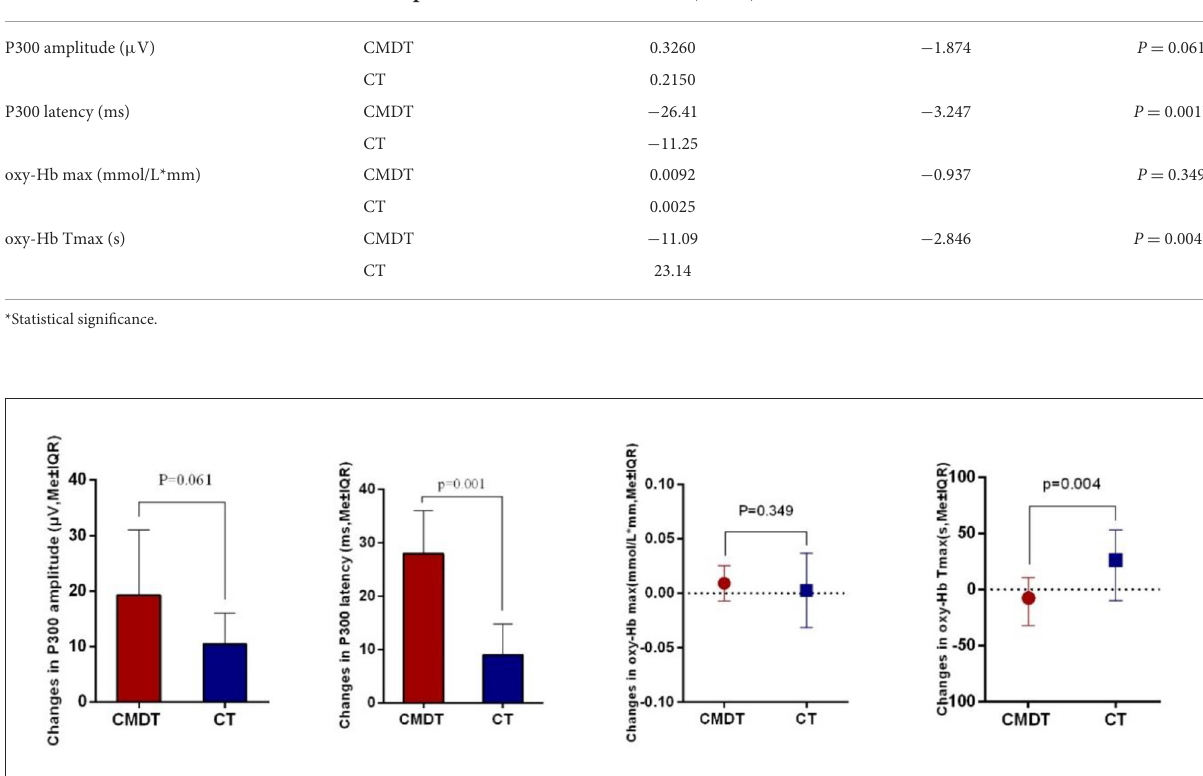
FIGURE4 Training effect on the secondary outcome measurement.